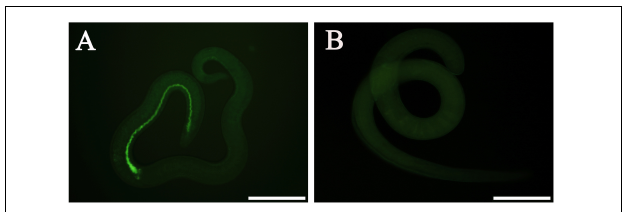
FIGURE 8 | Introduction of control siRNA by electroporation. (A) Introduction of FAM-labeled siRNA into the muscle larvae at 12 h after electroporation. (B) No green fluorescence was observed in the untreated larvae. Scale bars = 100 µ